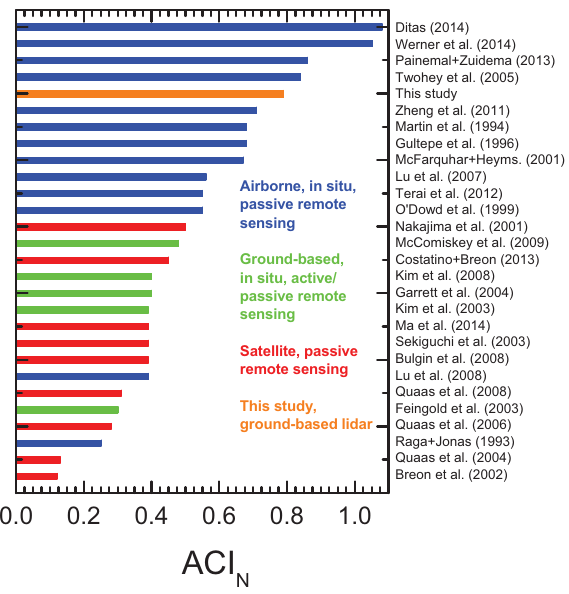
Figure 7. ACI N values as published in the literature (see references to the right). Different methods (in situ measurements, remote sens- ing) and observational platforms (aircraft, satellite, ground based) are used. The orange bar (this study) is taken from Fig. 5 (red bar, 30–70m above cloud